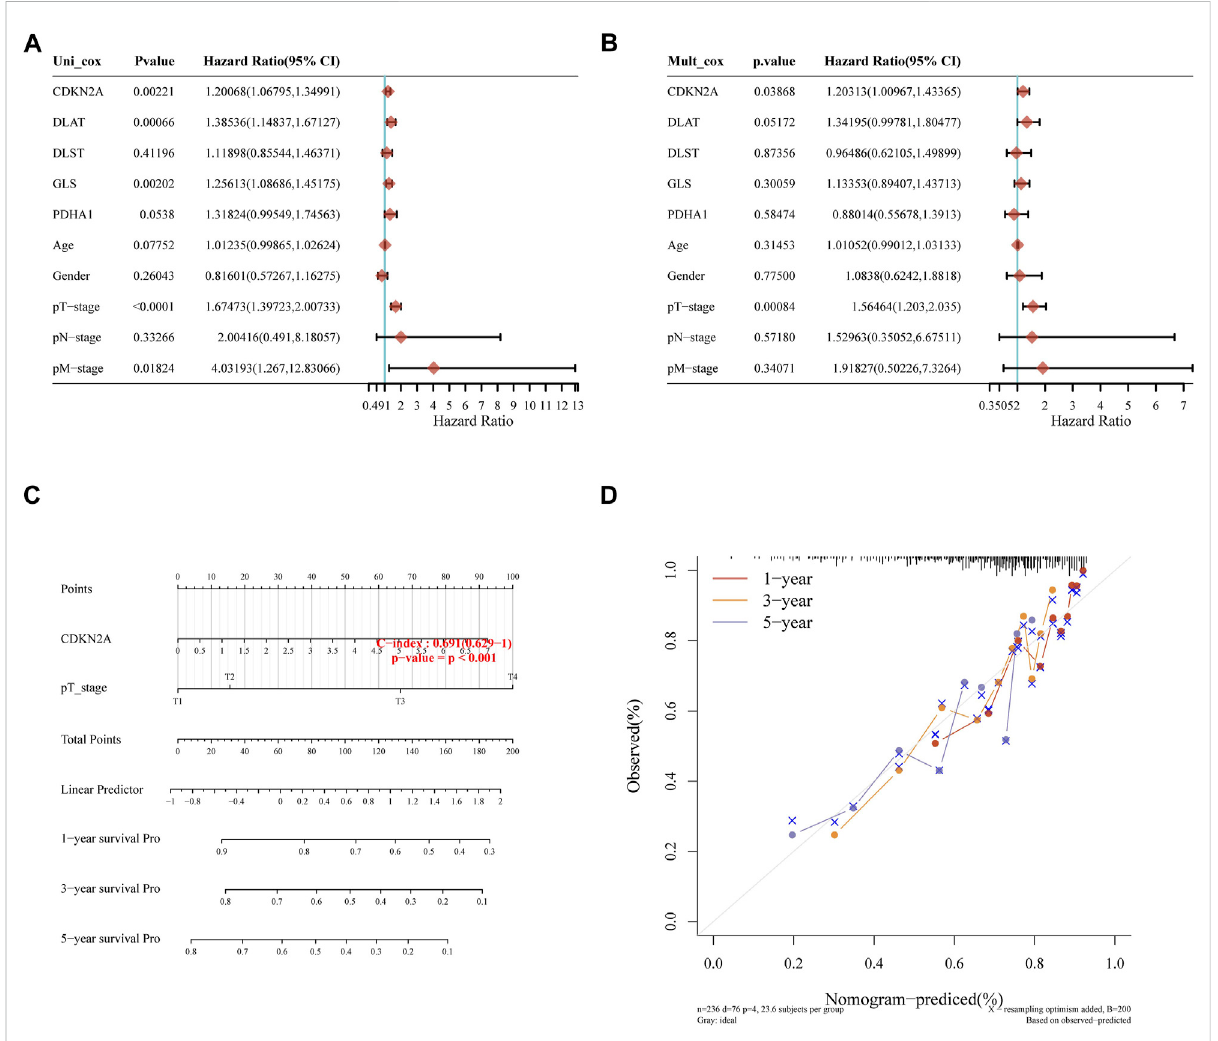
FIGURE 6 Constructing the predictive nomogram. (A) , (B) Hazard ratio and p -value of the constituents involved in univariate and multivariate Cox regression considering clinical parameters and fi ve prognostic CRGs in HCC. (C) The nomogram predicted the 1-year, 3-year, and 5-year overall survival rates of HCC patients. (D) Calibration curve for the overall survival nomogram model in the discovery